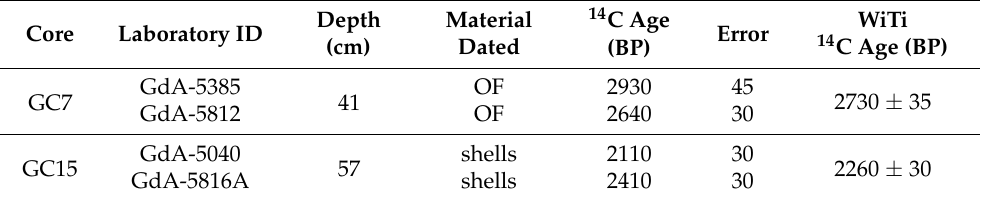
Table 1. Examples of 14 C dating performed on GC7 and GC15 by the GADAM Centre (Poland). The dating was done on the OF (fine < 63 µ m organic fraction of the sediment) and on bivalve shells. The WiTi 14 C age corresponds to the weighted average of 14 C age of two samples from the same depth. A complete dataset with all the dated samples is summarised in Table